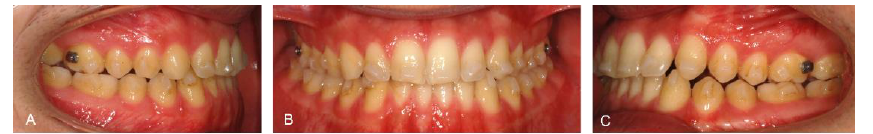
Figure 5. Intra-oral pictures of the patient after the first treatment phase: Right lateral occlusion ( A ); Frontal occlusion ( B ); Left lateral occlusion ( C ).